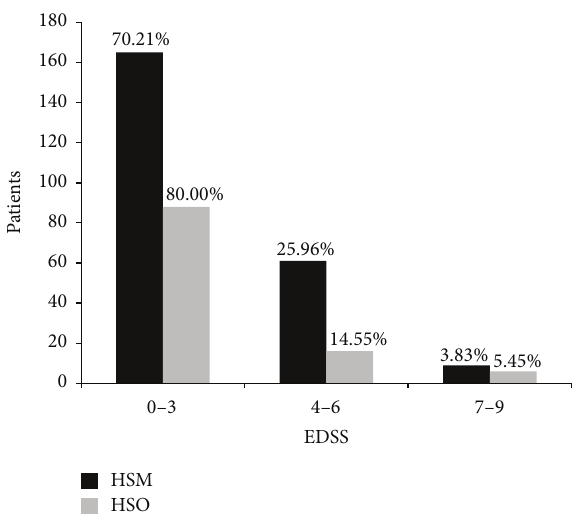
Figure 2: The patient distribution in these three EDSS groups is similar in both hospitals ( 𝑃 = 0.0549 ).